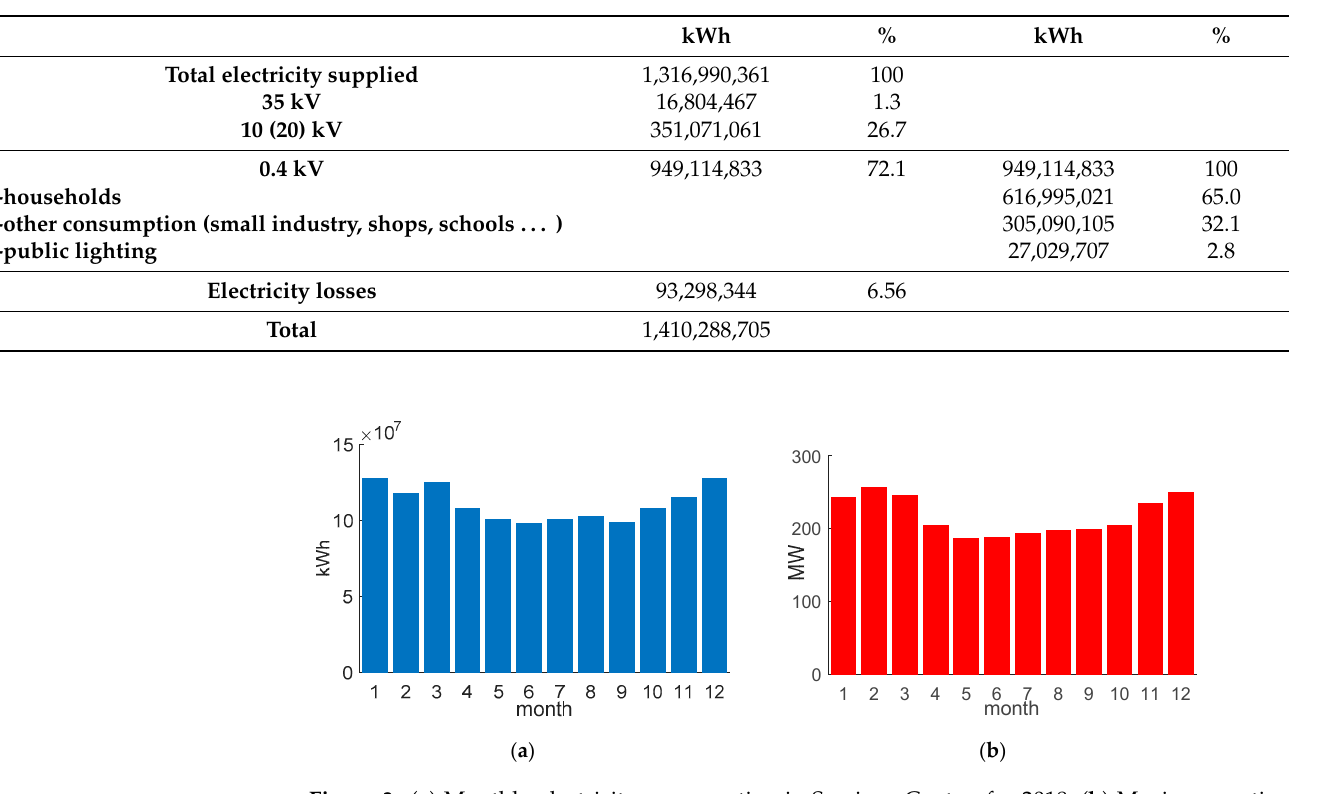
Table 5. Electricity consumption in Sarajevo Canton for 2018 [21].